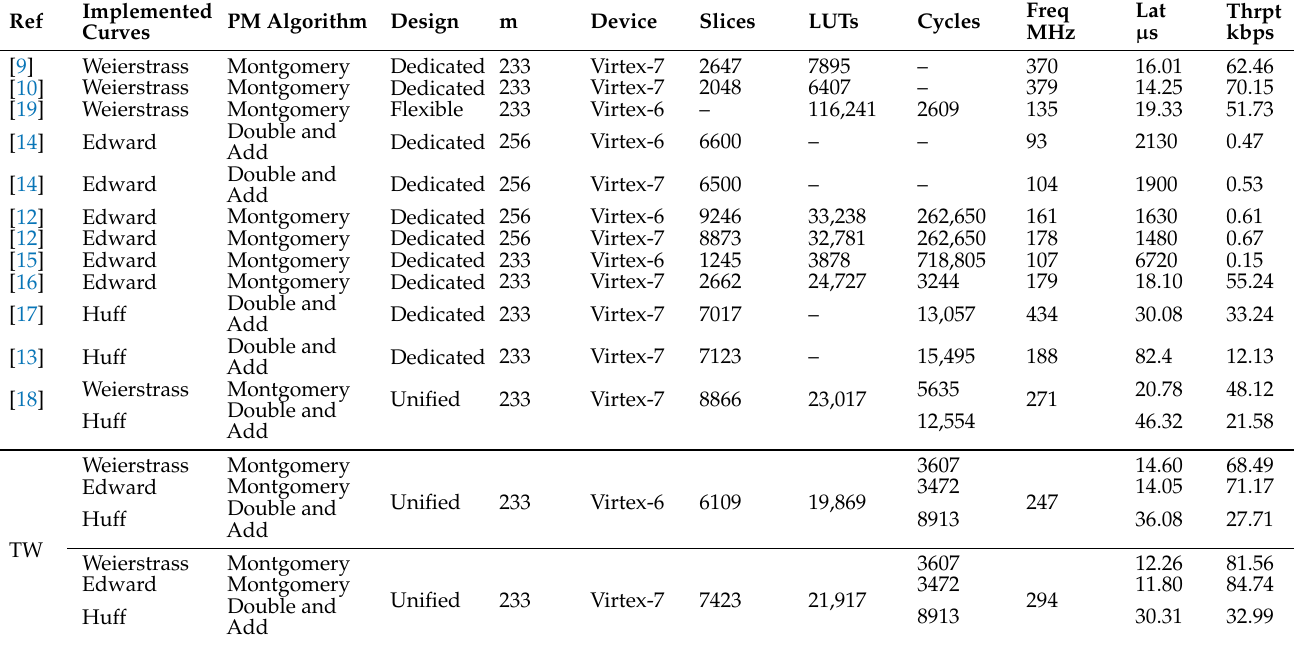
Table 4. FPGA comparison with the most recent PM architectures of the Weierstrass, Edward, and Huff